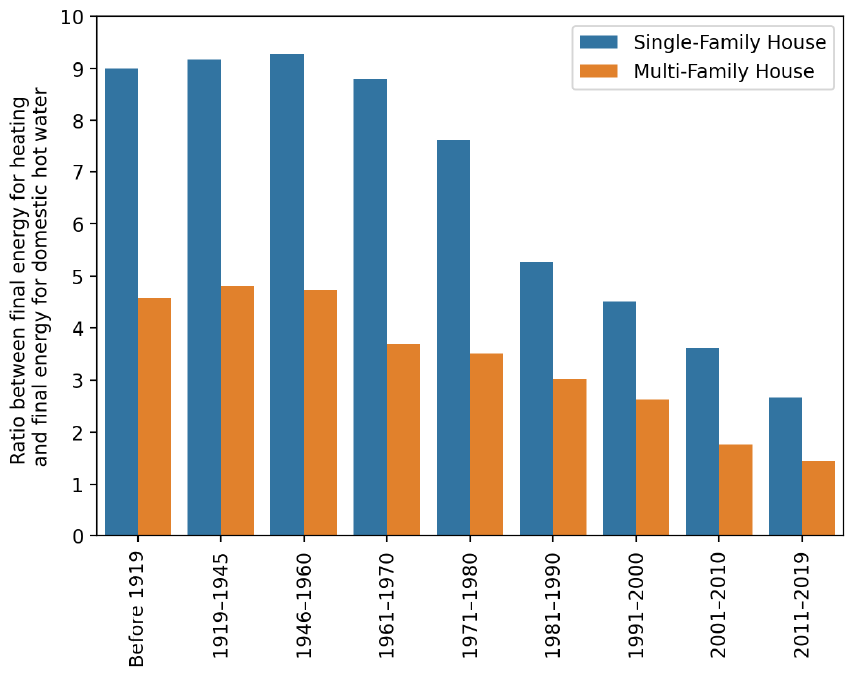
Figure 8. Ratio between the median final energy for heating and the median final energy for domestic hot water.